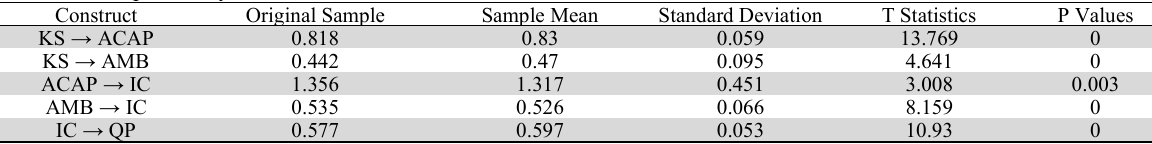
The results of path analysis Construct Original